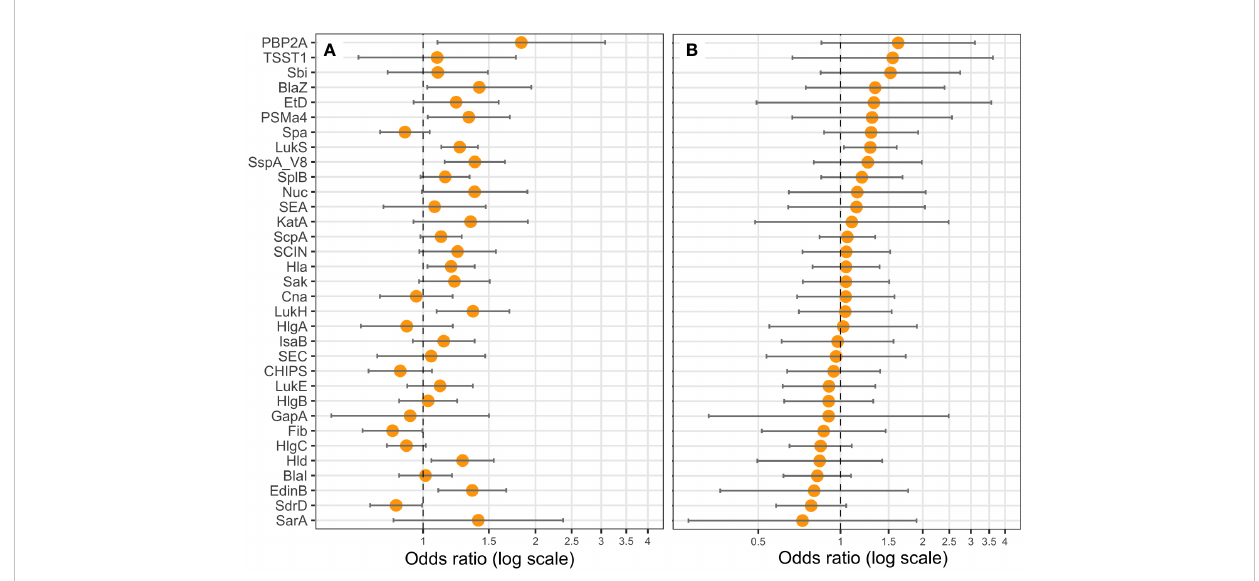
FIGURE 7 PVL (LukS-PV) expression is correlated with death. Logistic regression models including the Charlson Comorbidity Index score as covariate were performed, with either the expression level of (A) one protein (univariate), or (B) all proteins (multivariable) as explicative variables, and death as the response variable. Coef fi cients were reported as odds ratios (orange dots) with 95% con fi dence intervals (error bars). LukF-PV from LukSF-PV, LukG from LukGH, PSM a 1 from PSM a 1-4, and LukD from LukDE were removed from the statistical analysis to account for